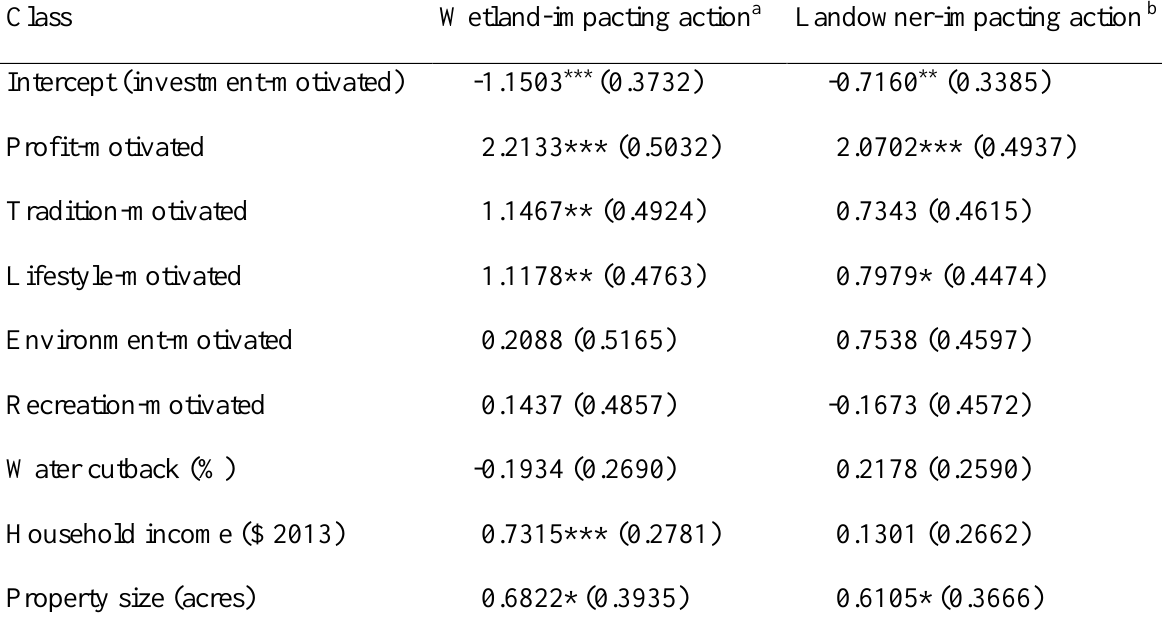
Table A1.2. Logistic regression coefficients (SE in parentheses) for Sierra Nevada foothills landowners’ management actions in response to a hypothetical water availability cutback (either 20, 50, or 100%; included as a continuous covariate) from all sources ( n = 274) . Asterisks (*, **, ***) denote significance at the 10, 5, and 1%